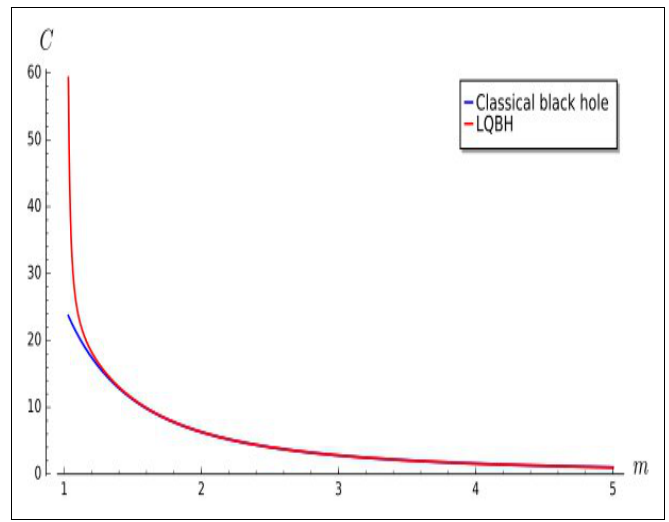
Figure 2. The correlation functions for a classical and for a LQBH. The results point to a substantial contribution to information recovery from LQBH’s front classical black holes. We have considered ω m = 0.2 (the peak of the emission spectrum